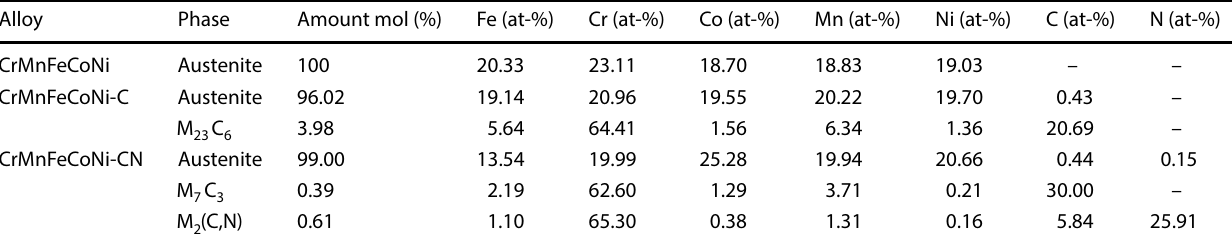
Table 2 Stable phases and their composition at 1323 K according to thermodynamic calculations, Thermo-Calc 2021 TCNI10